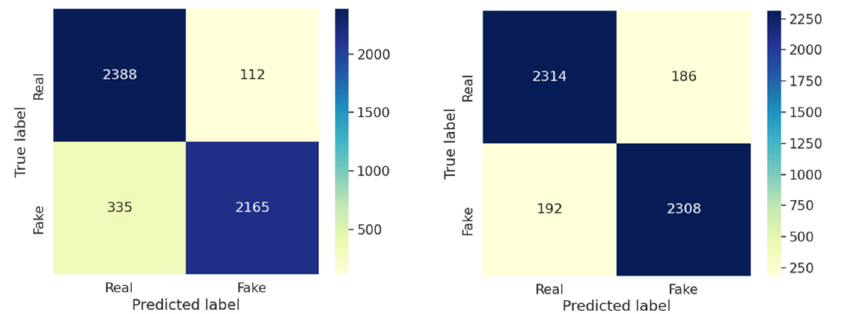
Figure 10. Confusion Matrix with DFDC dataset [19]; the left side is the SOTA model’s prediction which is described in Heo et al. [4] results and the right side is our results. Top-right, top-left, bot- tom-right, bottom-left means false-positive, true-negative, true-positive, false-negative in order.